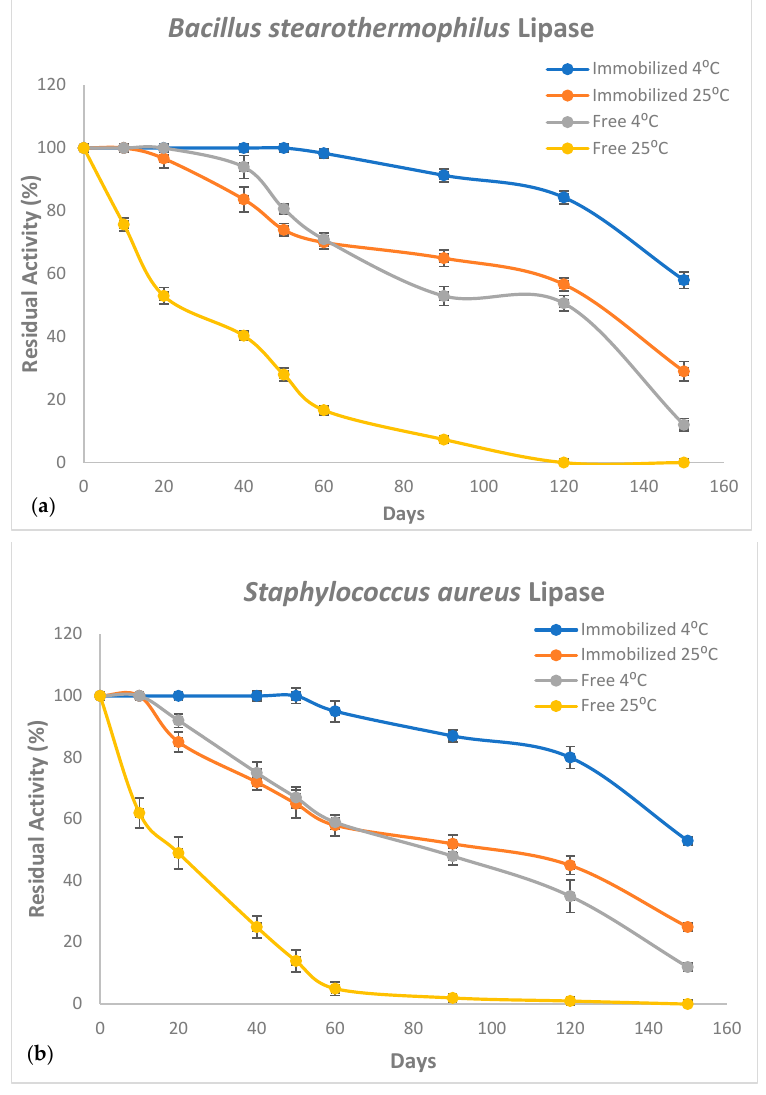
Figure 8. Activity retention rates (%) of CaCO 3 -immobilized and free and B. stearothermophilus ( a ) and S. aureus ( b ) lipases at 25 °C and 4 °C. Measurements were performed in triplicate and error bars indicate mean ± standard deviation.